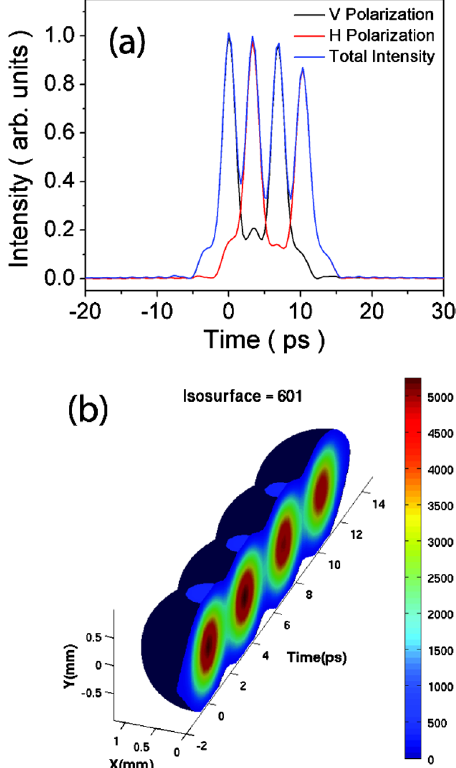
FIG. 6. Results of measurement of stacked soliton pulses: (a) the temporal intensity distribution obtained by cross corre- lation; (b) the three-dimensional intensity distribution, plotted as isointensity surfaces.